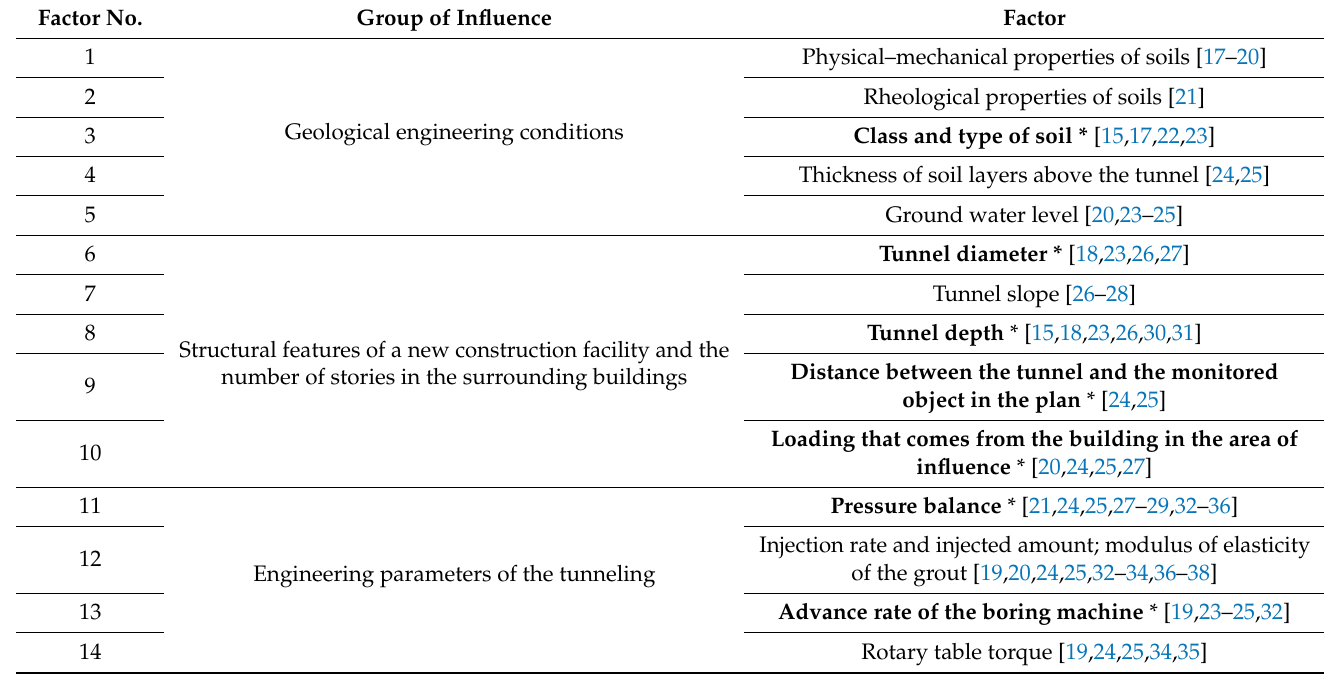
Table 1. The factors belonging to each group of potential influence on the supplementary displace- ment of the soil body in the process of